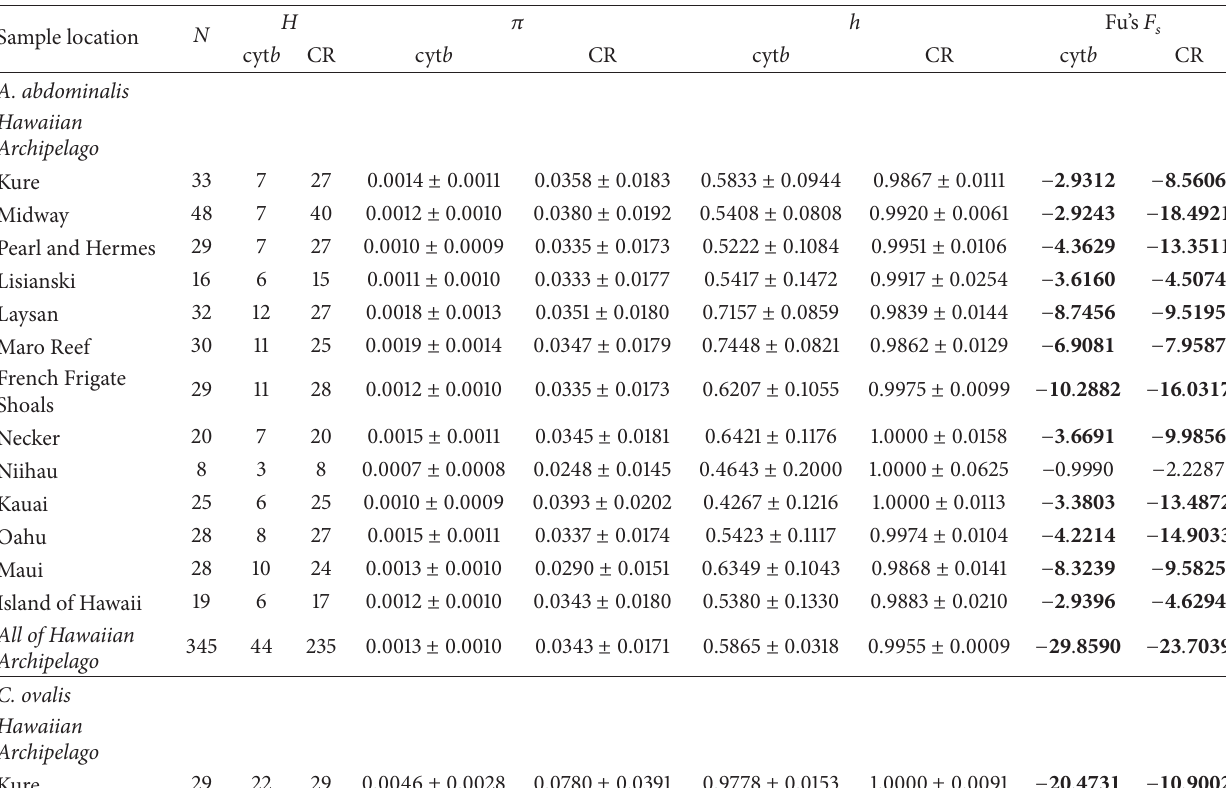
Table 1: Molecular diversity indices for A. abdominalis , C. ovalis , and C. verater . Number of individuals ( 𝑁 ), number of haplotypes ( 𝐻 ), nucleotide diversity ( 𝜋 ), haplotype diversity ( ℎ ), and Fu’s 𝐹 𝑠 are listed for cyt b and CR. 𝐹 𝑠 values in bold are significant ( P < 0.05). For A. abdominalis , populations at Gardner Pinnacles ( 𝑁 = 1 ) and Nihoa ( 𝑁 = 1 ) were not included in most analyses due to small sample